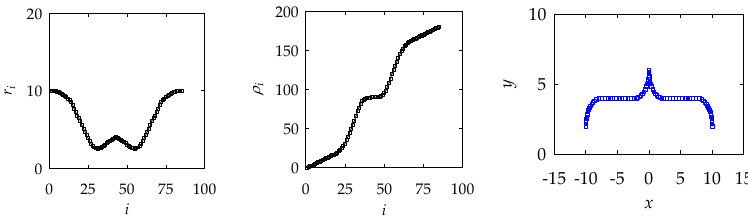
Figure 10. Point-clouds of Ayusi created using the algorithmic approach.